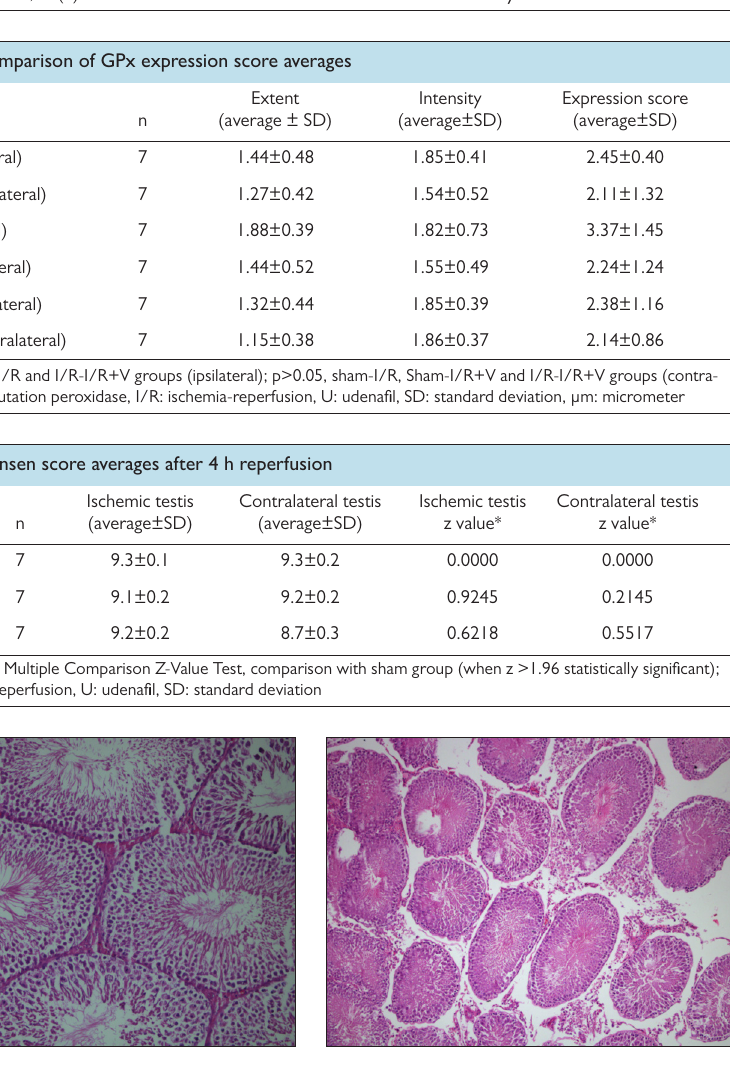
Figure 1. Seminiferous tubules in the regular structure, Sham, HEx200